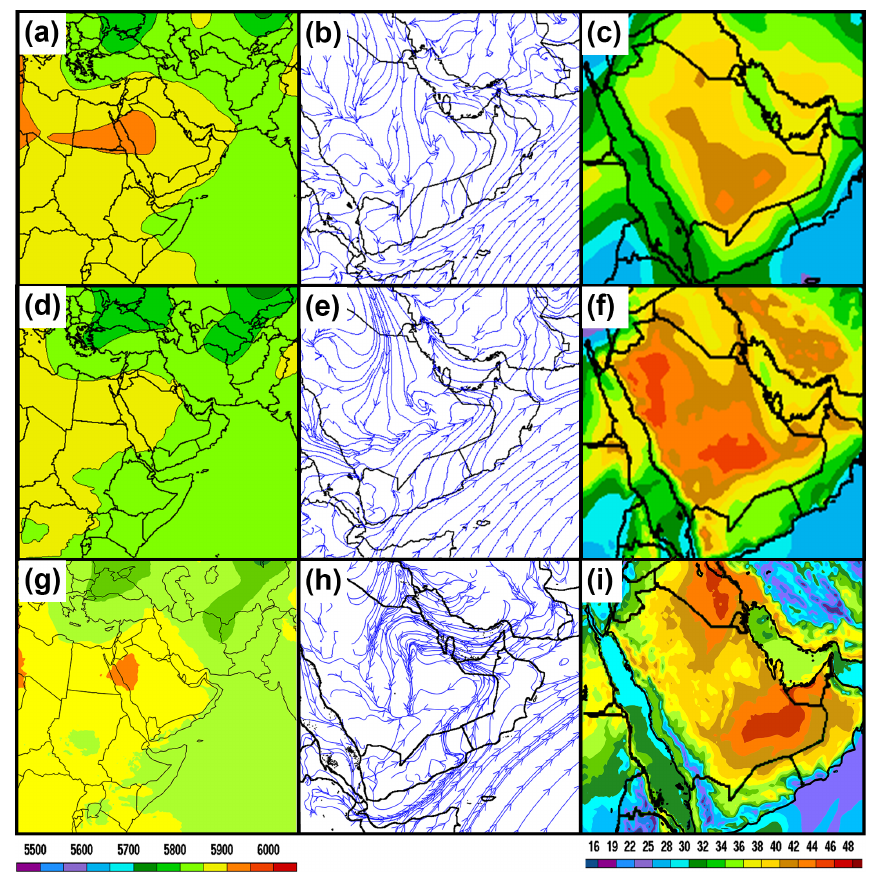
Figure 3. 4 August 2016 at 00:00UTC: (a, d, g) 500mb geopotential height (m), (b, e, h) 925mb streamlines, and (c, f, i) 1000mb temperature ( ◦ C) from (a–c) GDAS-FNL, (d–f) RAMS Grid 1, and (g–i) WRF-Chem Grid